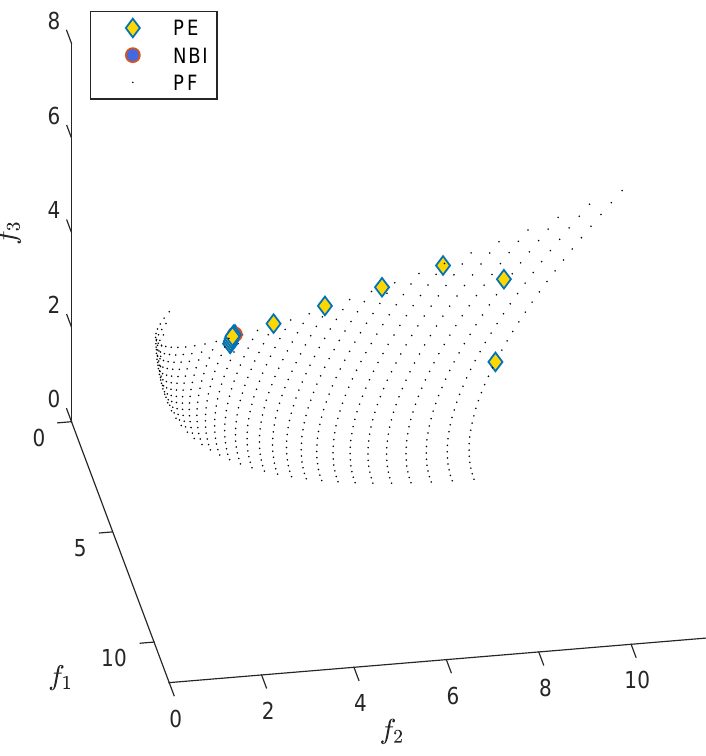
Figure 6. Numerical results for MOP 14.